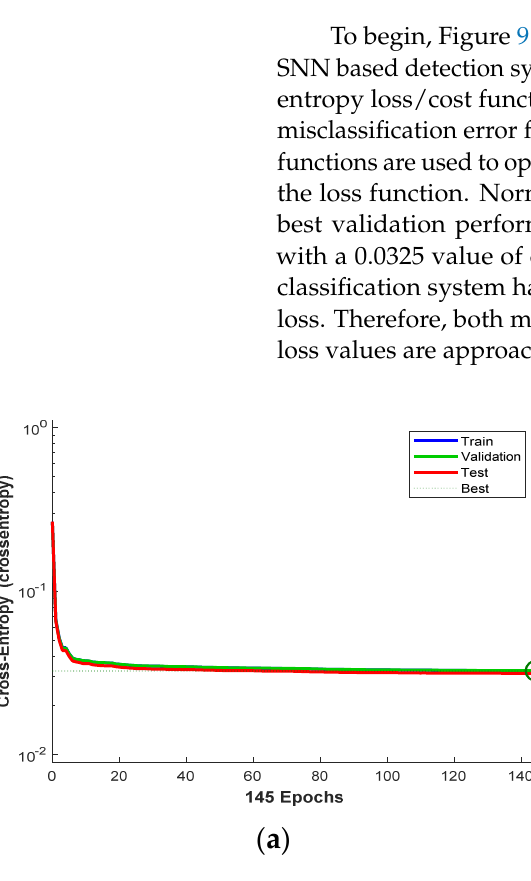
Figure 9. Performance analysis trajectories using cross-entropy cost for ( a ) SNN based detection system and ( b ) SNN based classification